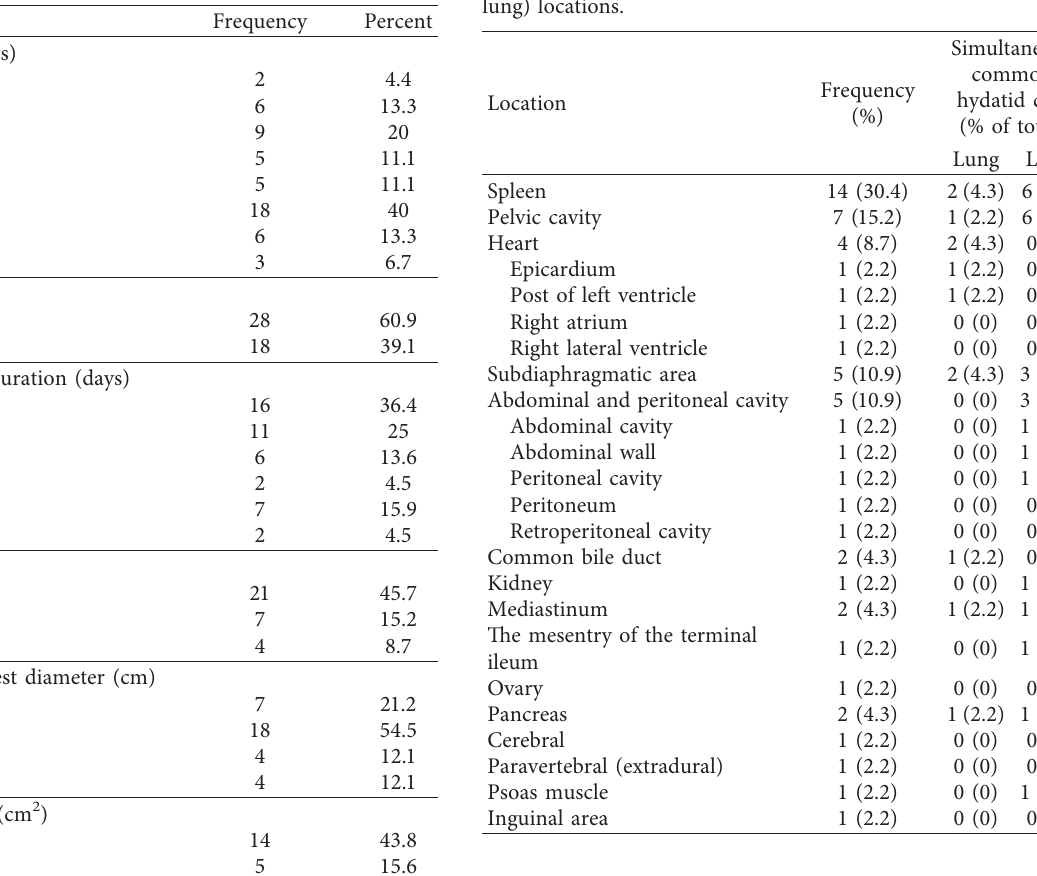
Table 1: Demographic and clinical features of patients diagnosed with hydatid cyst of unusual locations.